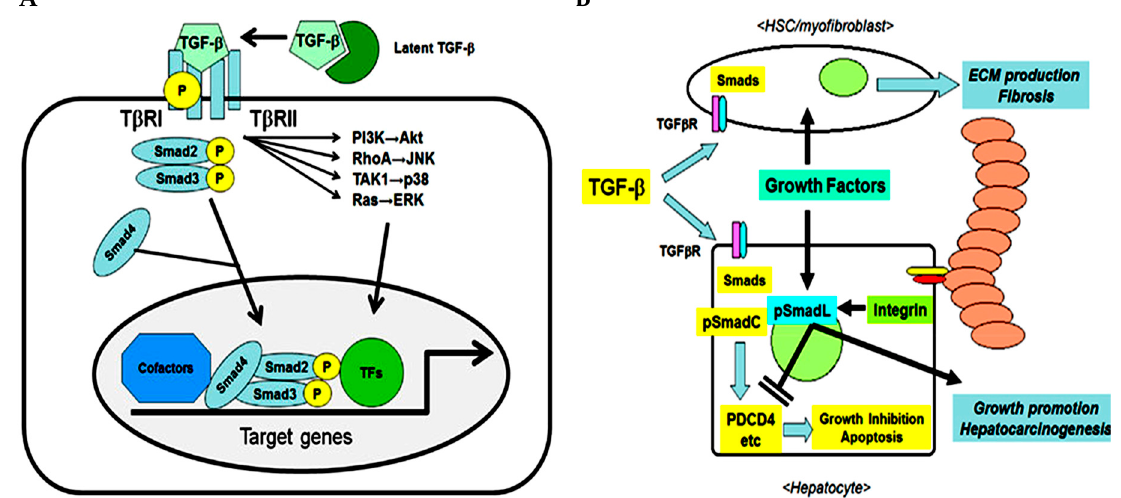
Figure 1. Transforming growth factor (TGF)- β pathway in fibrotic liver which can lead to hepatocellular carcinoma. ( A ) TGF- β as trigger of cellular response ( B ) TGF- β in the cross-talk between hepatocytes and microenvironment (Under Creative Commons Attribution (CC BY) license from: Ozaki et al. [3].